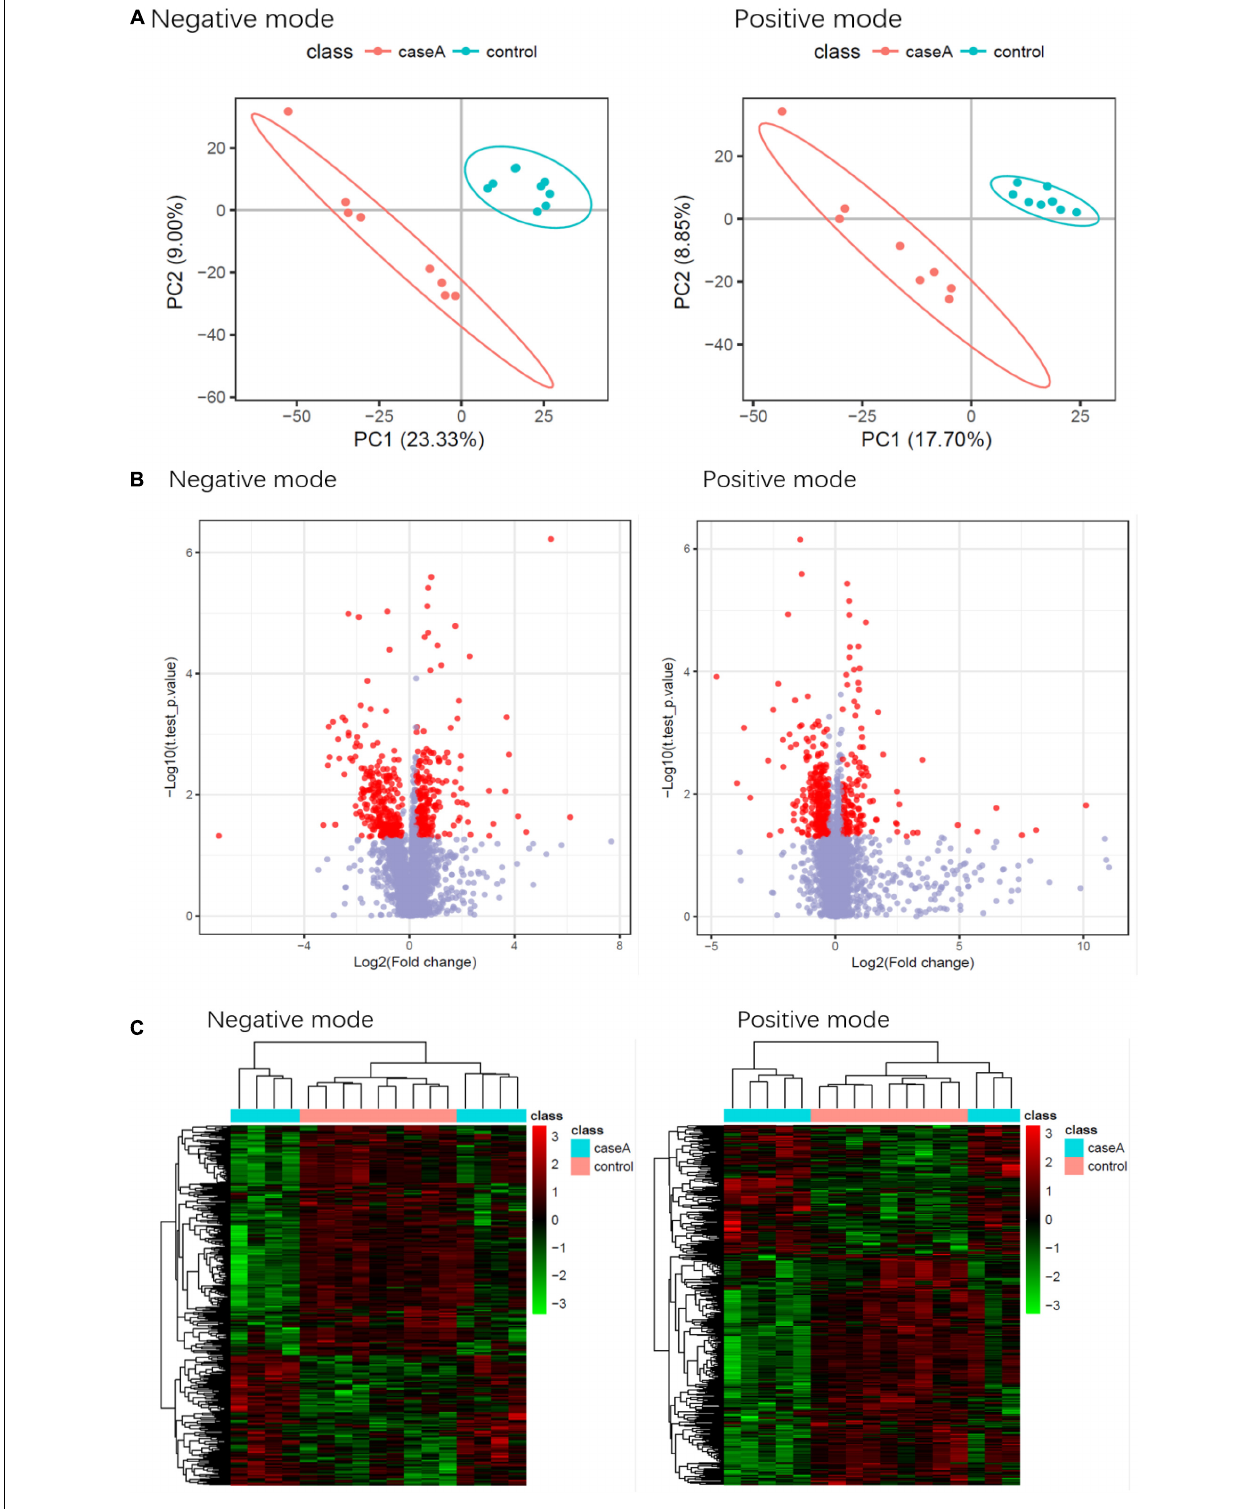
FIGURE 10 | Results of the metabolomic comparison of patients with SAA and healthy controls in both positive and negative mass spectrometric ion modes. (A) PLS-DA, (B) Visual volcanic map, (C) heatmap.